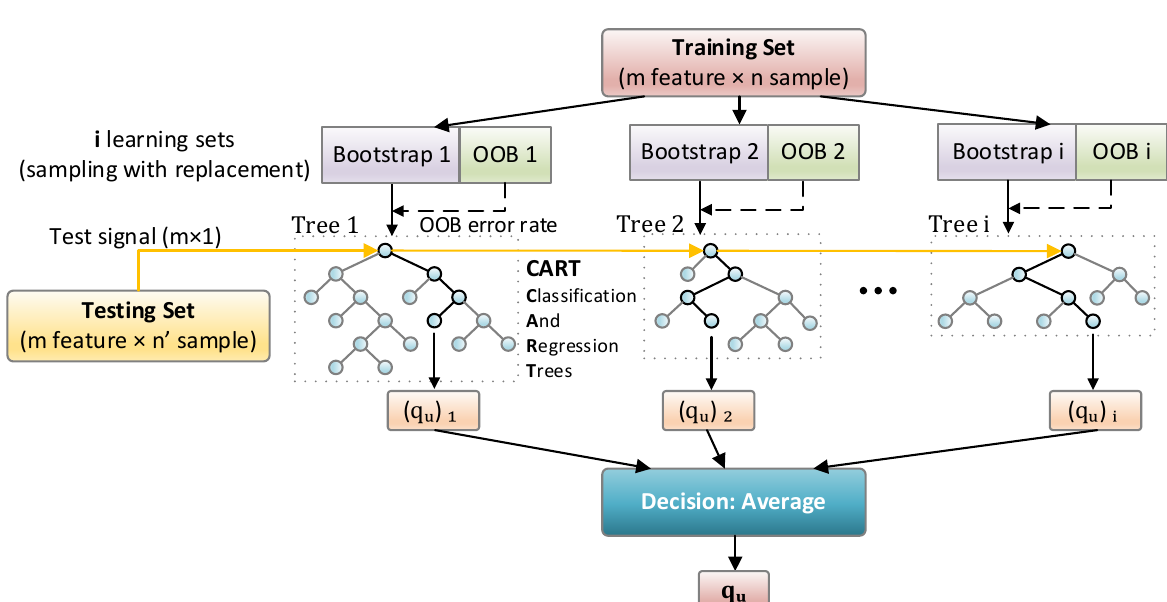
prediction 𝑞𝑞 𝑢𝑢